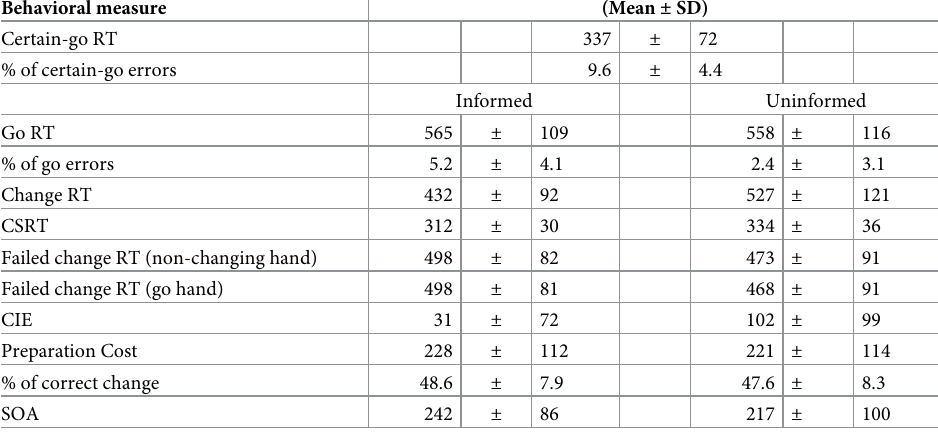
Table 1. Reaction times (mean, standard deviation) for go and change trials separated for trials with (informed) and without foreknowledge (uninformed). Behavioral measure (Mean ± SD) Certain-go RT 337 ± 72 % of certain-go errors 9.6 4.4 Informed Go RT 565 % of go errors Change RT 121 CSRT 312 ± 30 334 ± 36 Failed change RT (non-changing hand) 498 ± 82 473 ± 91 Failed change RT (go hand) 498 CIE 112 114 % of correct change 48.6 SOA 242 ± 86 217 ± 100 Failed change RT is the RT in change trials in which participants responded with a go response. CIE = change interference effect; CSRT = change signal reaction time; RT = reaction time; SOA = stimulus onset asynchrony.